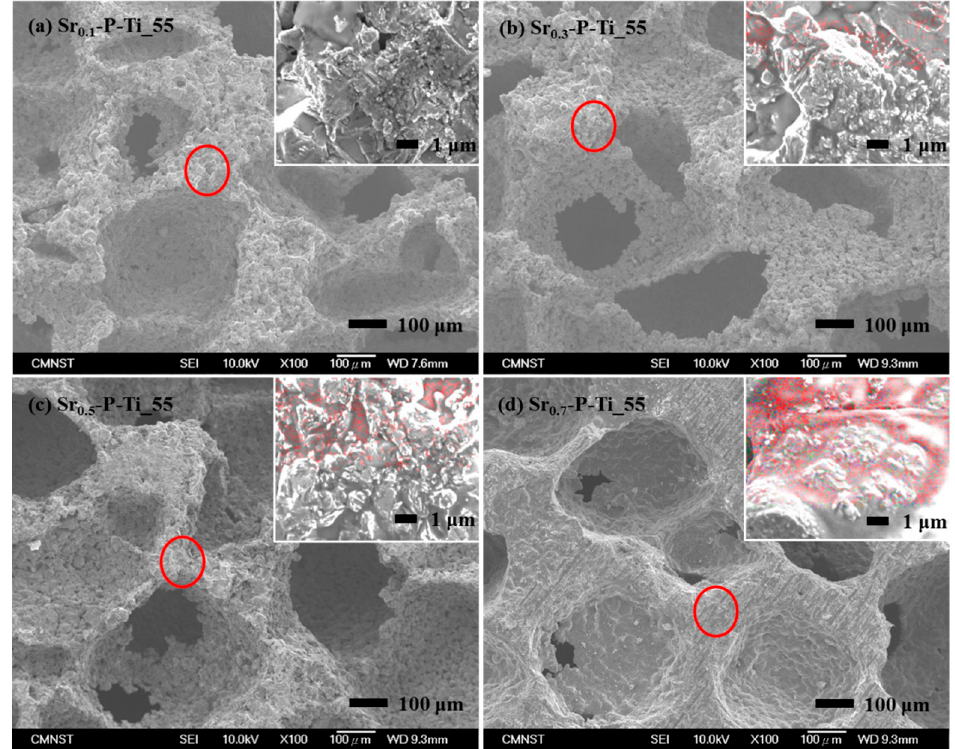
Figure 2. SEM morphologies from the cross-sectioned surfaces of Sr x -P_Ti_55, x = ( a ) 0.1, ( b ) 0.3, ( c ) 0.5, and ( d ) 0.7. Their top-right images were taken from EDS element mapping; the red color is the element Sr.